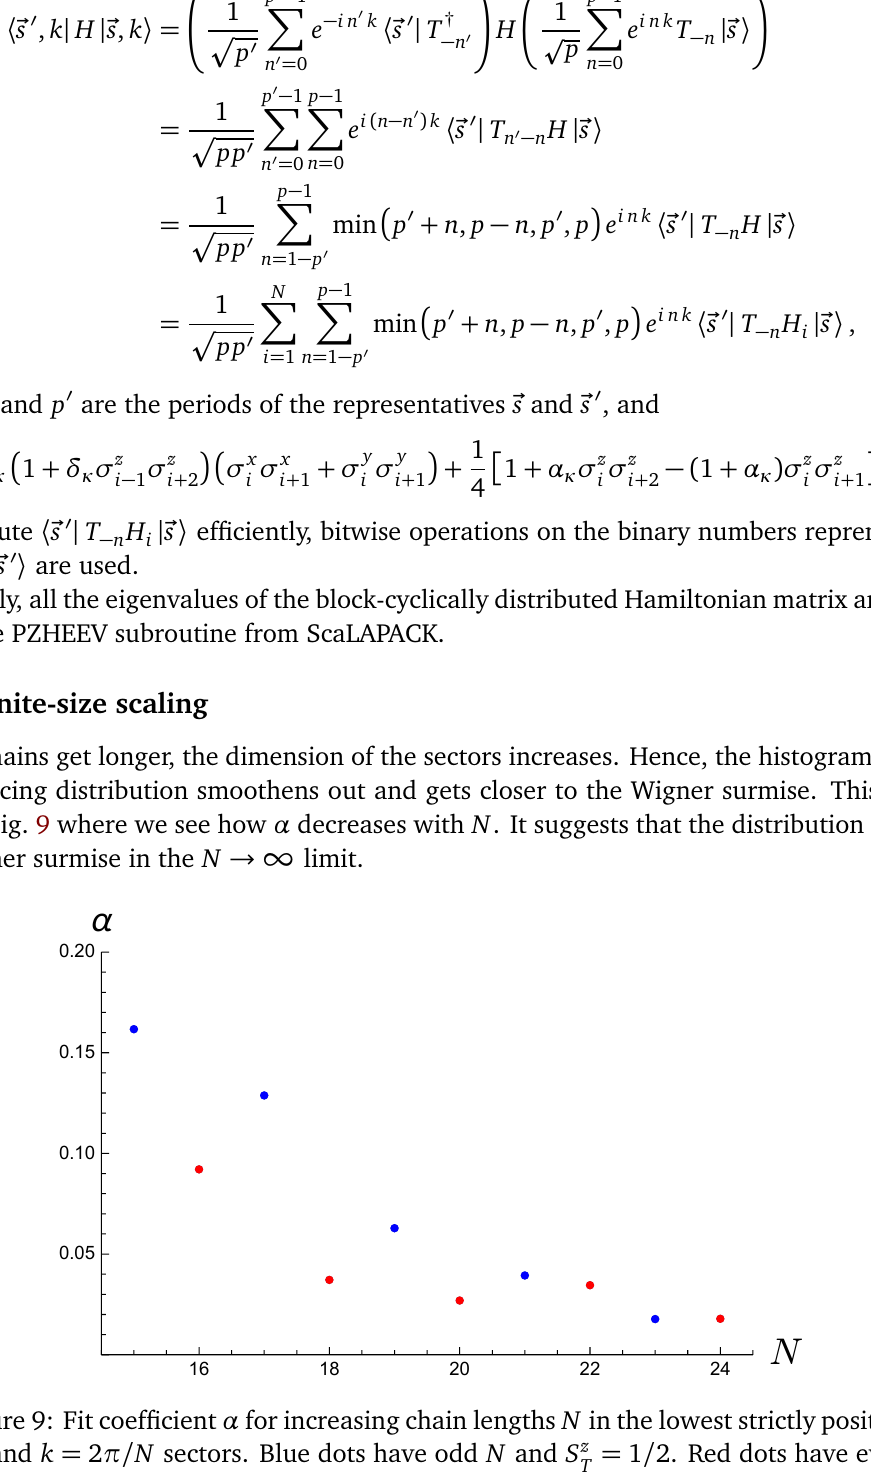
= 1 / 2. Red dots have even T